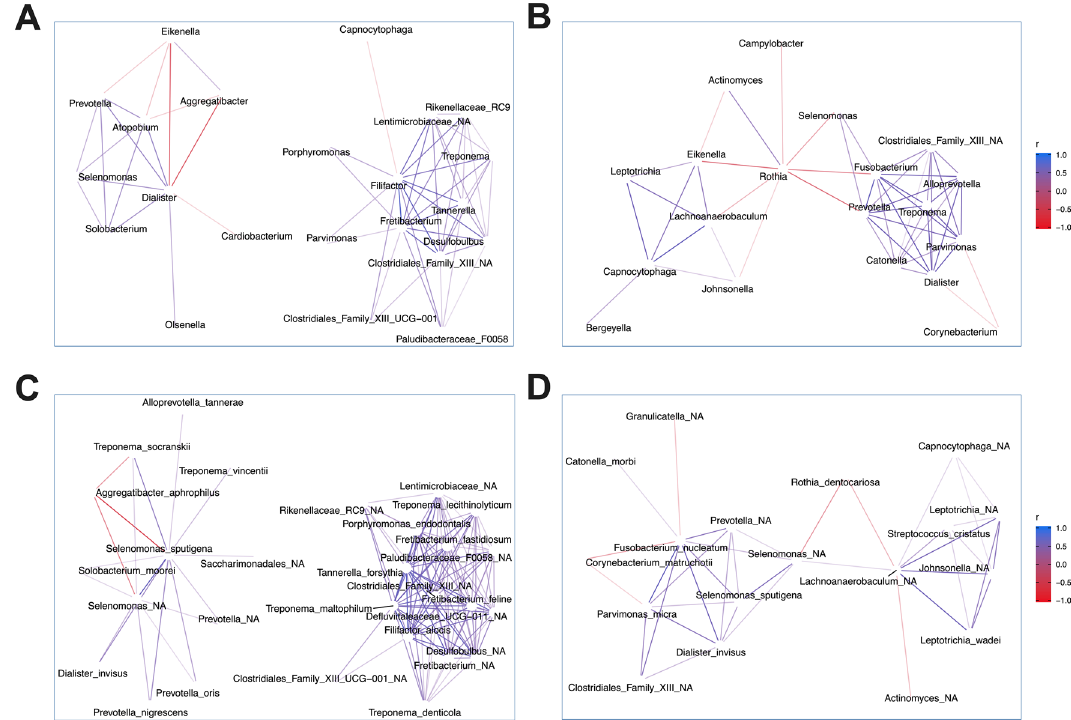
Figure 5. Bacterial association networks. Association networks were constructed between abundant genera and species based on correlation circle plots derived from principal component analysis at each timepoint. ( A ) Genus-level network at baseline, ( B ) genus-level network at day 90, ( C ) species-level network at baseline, ( D ) species-level network at day 90. Only associations < − 0.4 (negative associations) and > 0.4 (positive associations) are